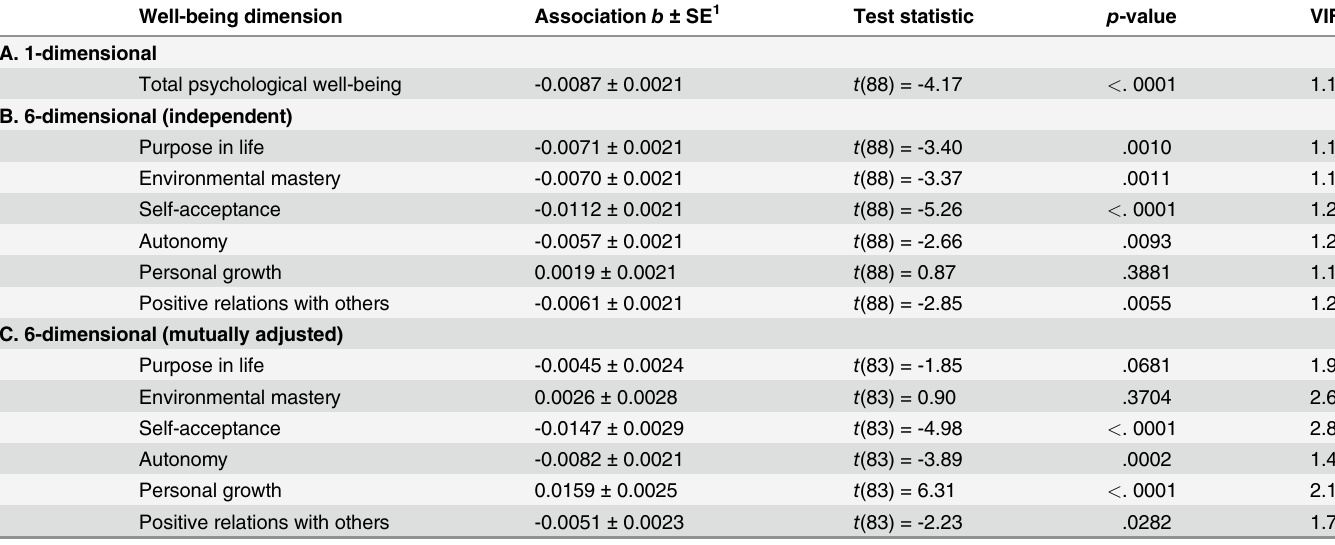
Table 5. Association of psychological well-being with gene expression: Generalization